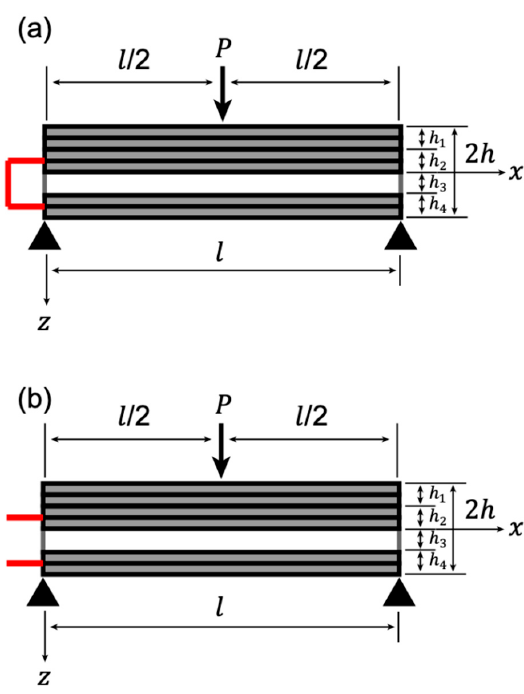
Figure 6. Schematic of a centrally loaded composite beam for three-point bending test: ( a ) short circuit condition; ( b ) open circuit condition.